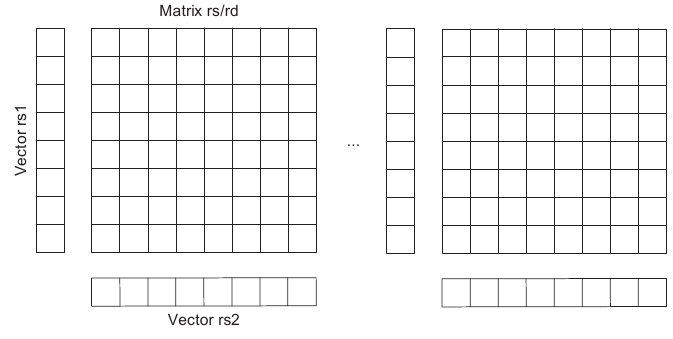
Figure 6. The custom matrix registers